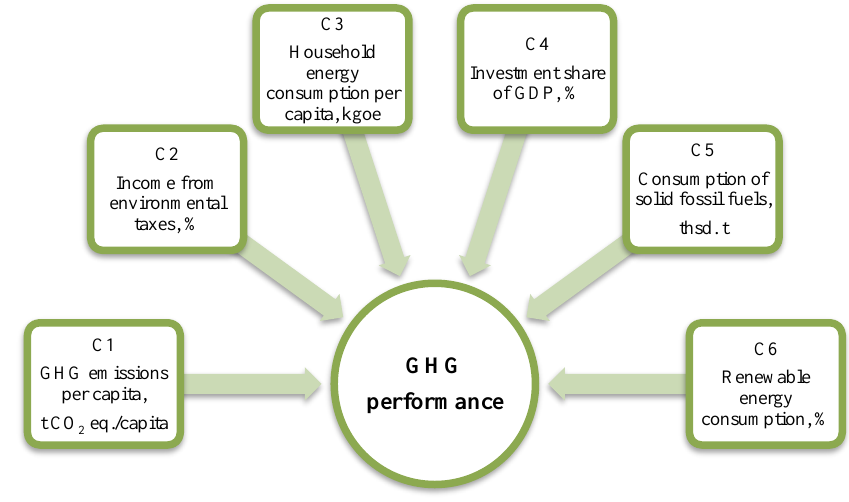
Fig. 3. GHG performance